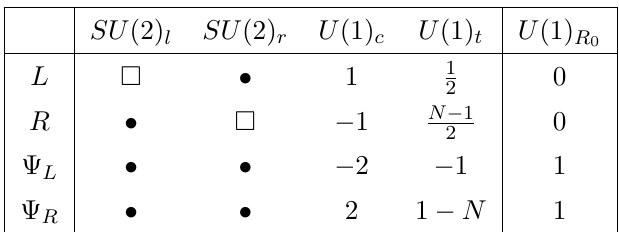
Table 5 . Transformation rules under the global symmetry of the 2 d matter fields coming from the dimensional reduction of theory T 4d A